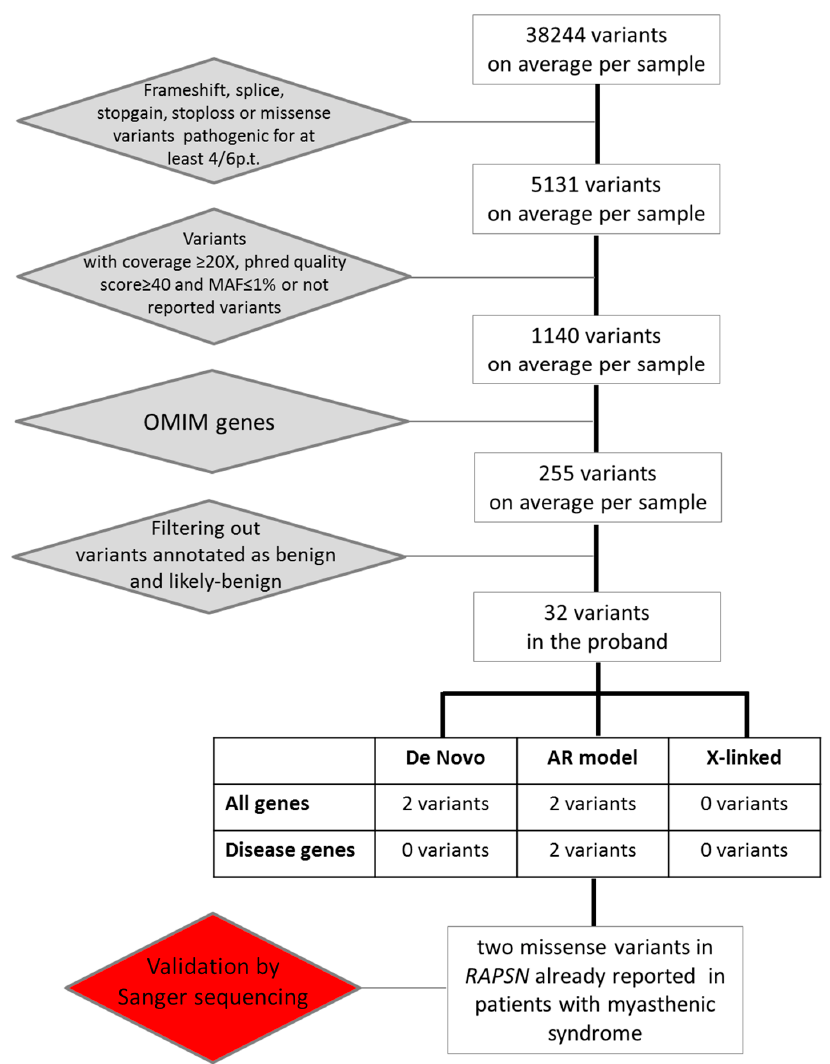
Figure 2. Flowchart illustrating filtering process and variants selection used to identify pathogenic variations.